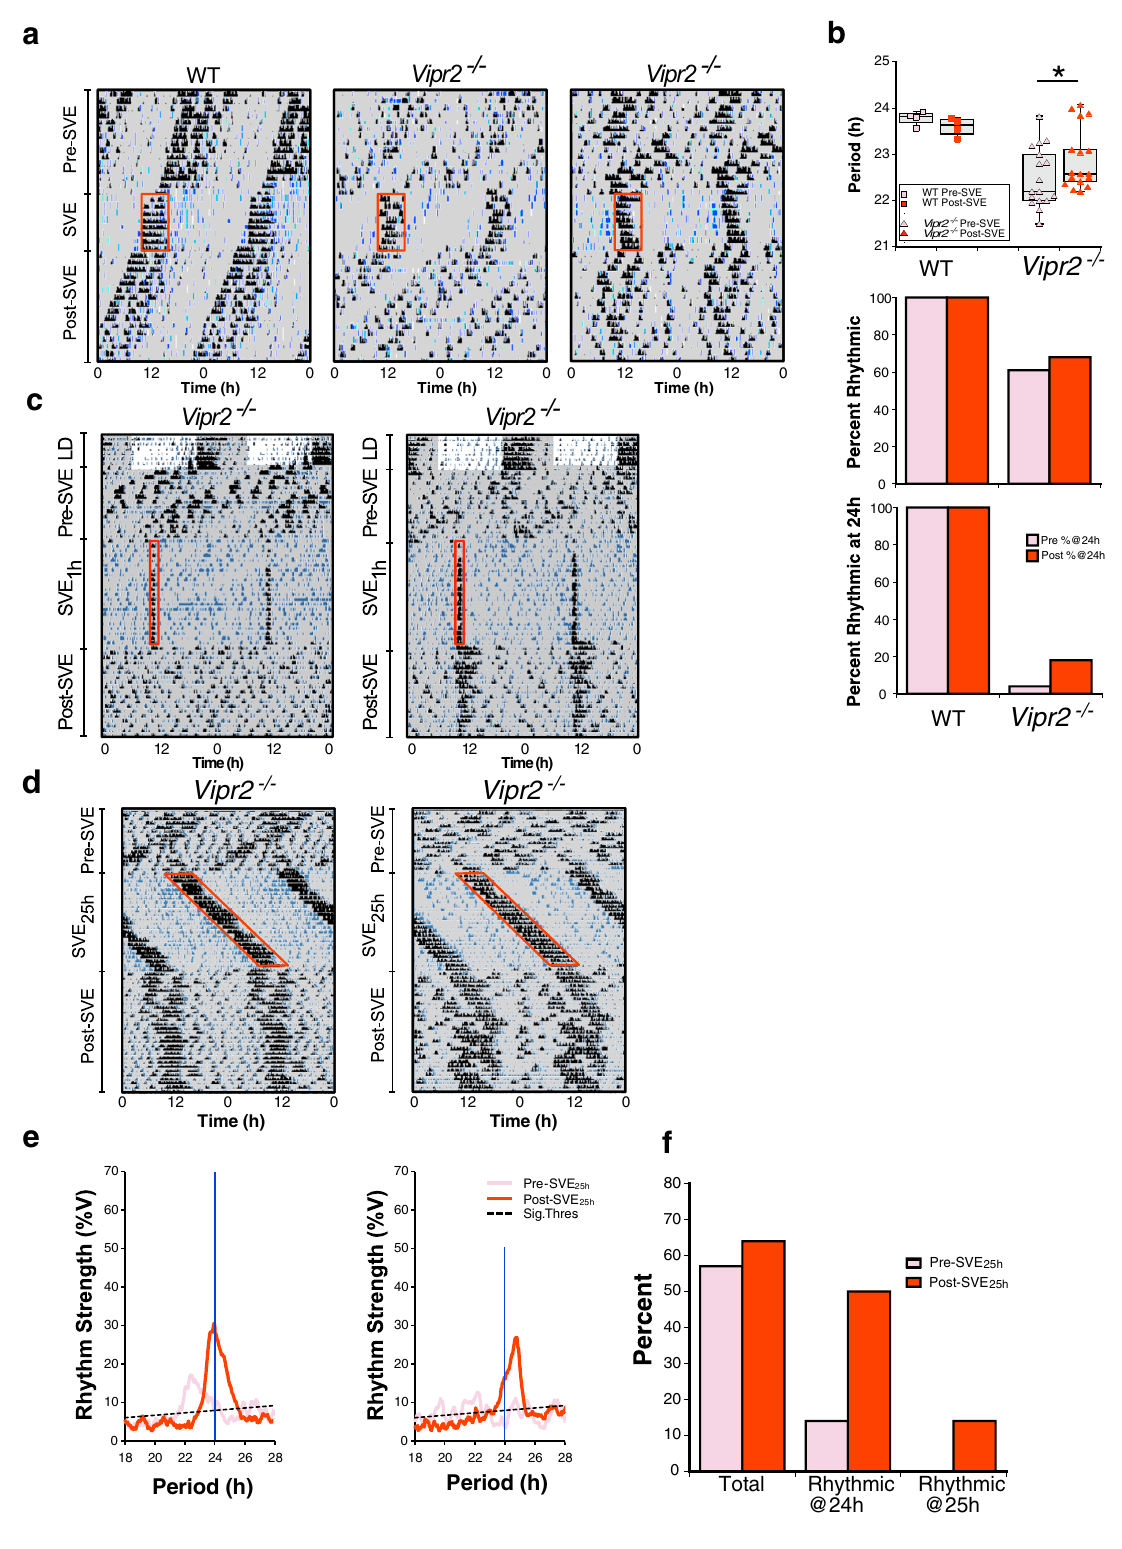
(Fig. 4c – f and Table S1). This is consistent with previous reports of the reduced fi ring activity of adult SCN neurons in Vipr2 − / − mice 7,27 . The already low spontaneous fi ring of Vipr2 − / − vSCN neurons was not signi fi cantly altered by SVE. In WT mice, spontaneous fi ring tended to be lower in animals exposed to timed wheel-running but only signi fi cantly so for SVE(1) mice (Fig. 4c – e and Table S1). This indicates that exposure to